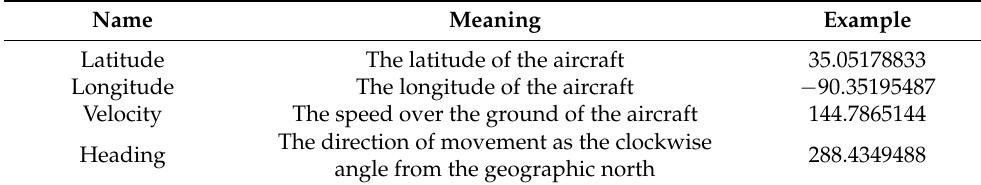
Table 1. ADS-B data sample.